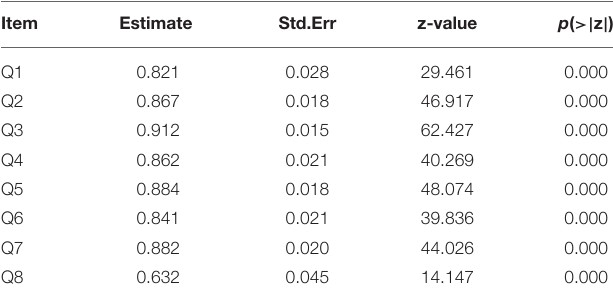
TABLE 1 | Loading estimates of the confirmatory factor analysis